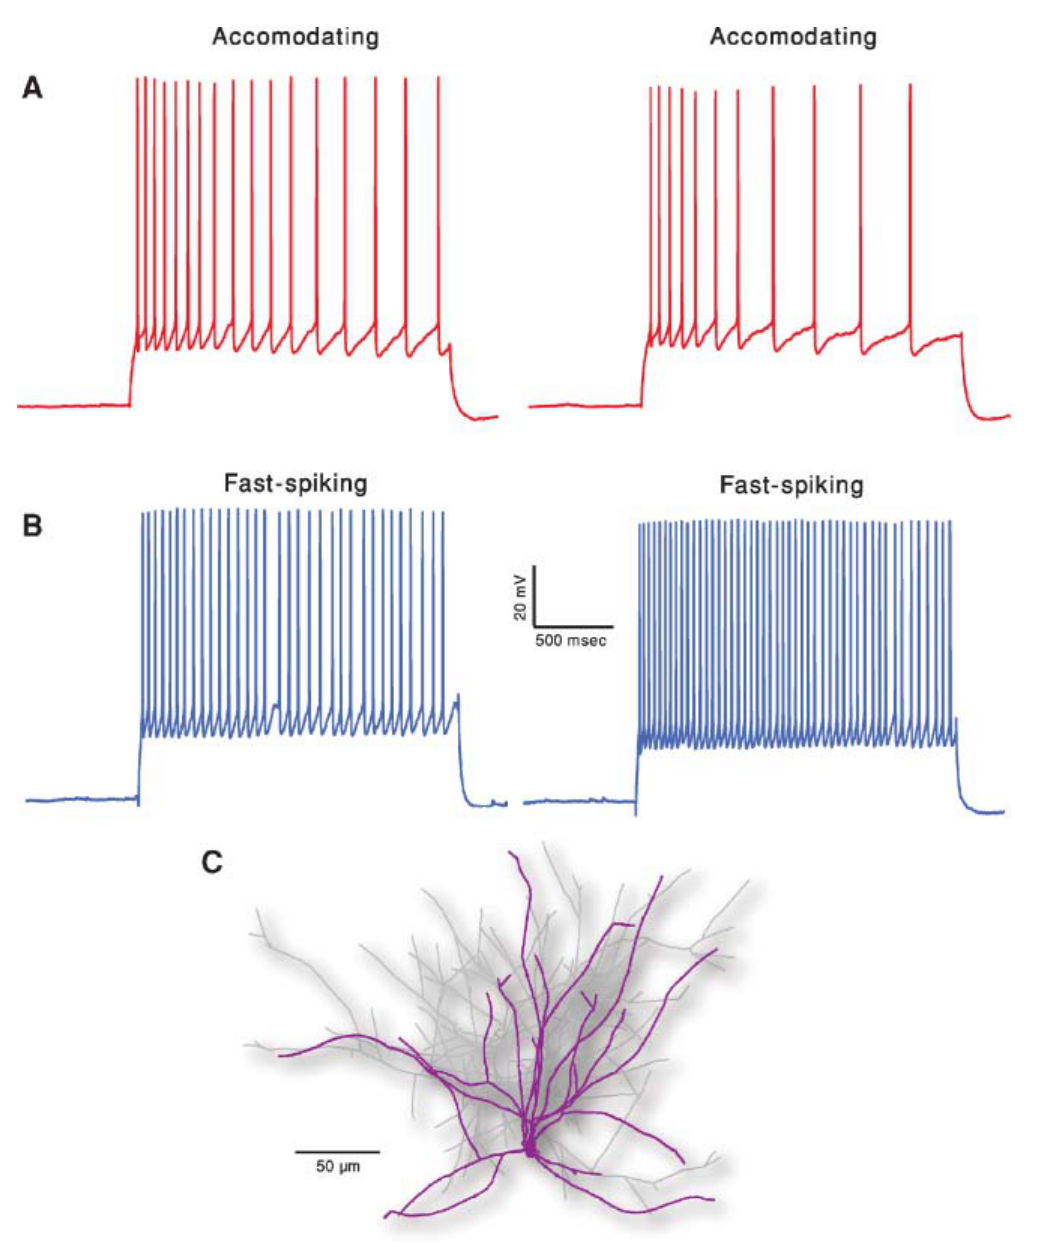
Figure 1. Two classes of firing patters in cortical interneurons . (A) Accommodating interneuron (red traces). Two experimental responses of the same cell to a 2seconds long, 150pA depolarizing current. Time elapsed between the two responses is 10seconds. (B) Fast spiking interneuron (blue traces). Same current input as in A . Membrane potential of all cells was shifted to − 70mV prior to the current step injections. Note that these two exemplars of the electrical classes are clearly distinct and that, for a given cell, there is a considerable variability between traces although the current input remains exactly the same (e.g., number of spikes and spike timing). (C) Reconstructed nest basket cell interneuron used for simulations. Dendrites are marked in purple and axon in light gray.